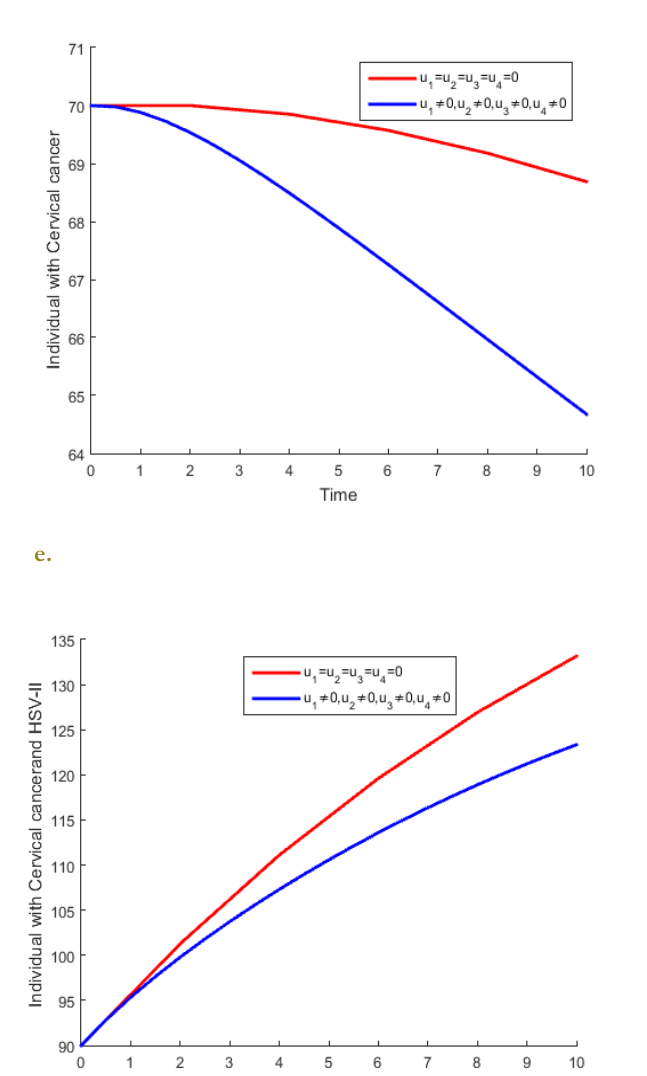
Fig. 5. Simulations showing optimal use of both prevention and treatment.